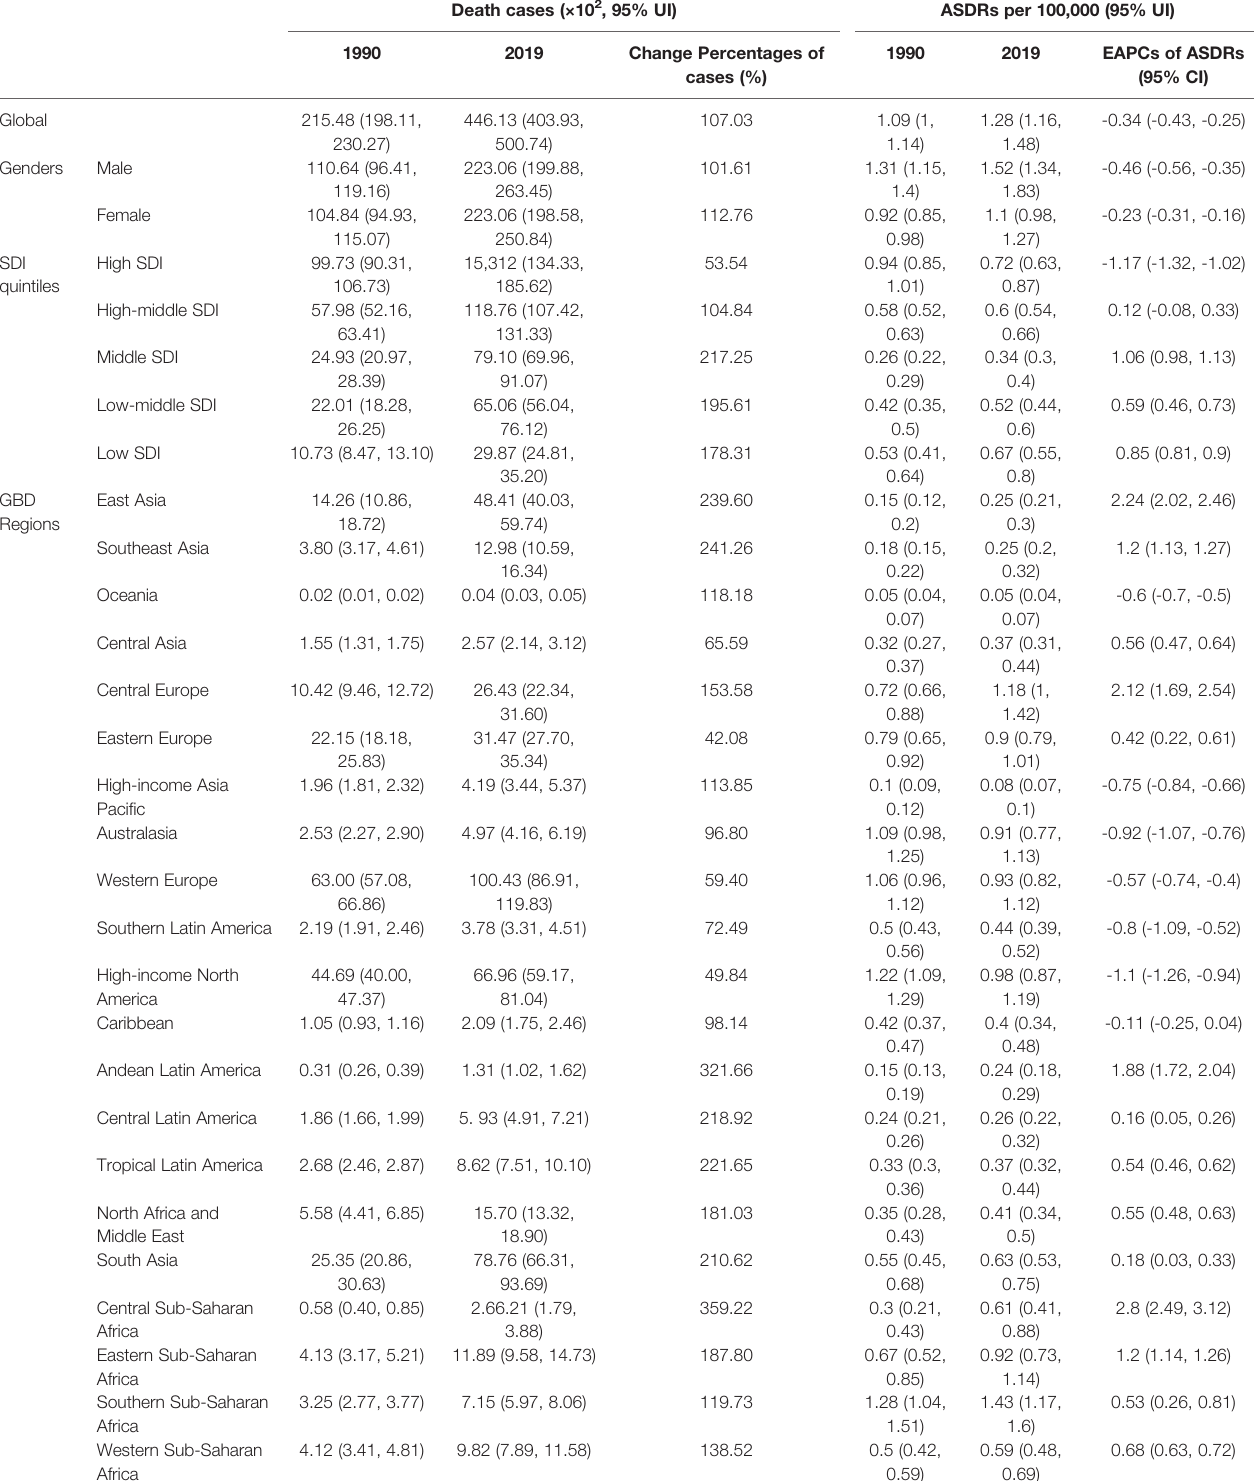
TABLE 2 | The death cases and ASDRs of CLL in 1990 and 2019, and the trends from 1990 to